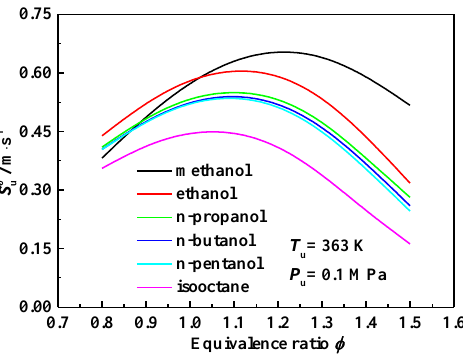
Figure 7. Simulations of C1–C5 primary alcohols and isooctane at 363 K and 0.1 MPa using the mechanisms proposed by Sarathy et al. [25] and Chaos et al. [59], respectively.